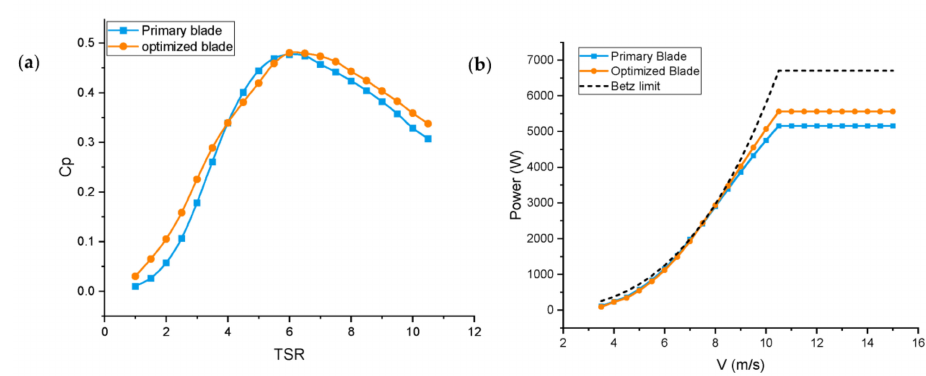
Figure 9. ( a ) power coefficient with tip speed ratio, ( b ) Power output with wind speed.